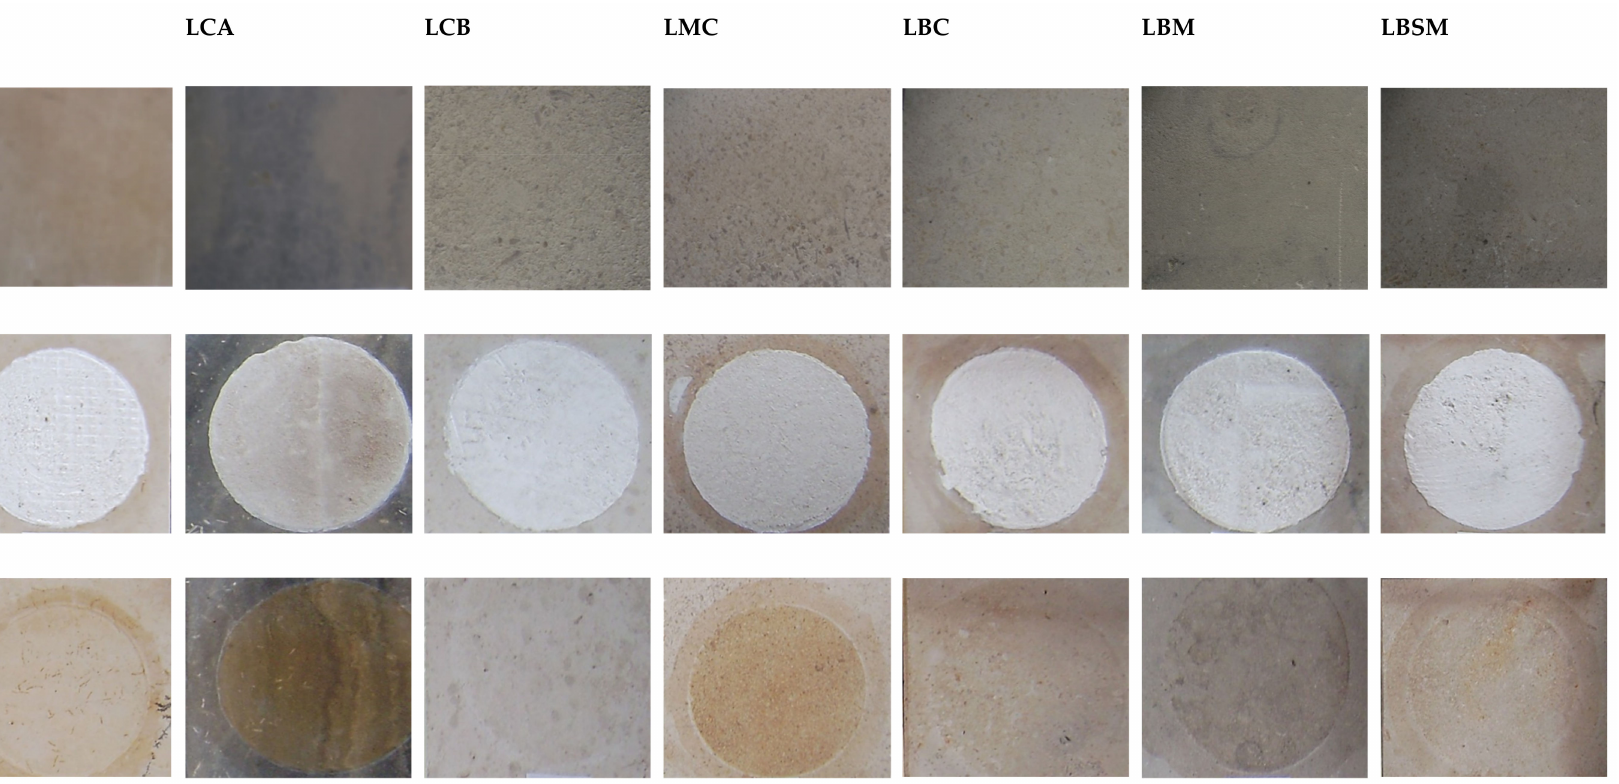
Figure 8. Samples of limestone stones before and after exposure to citric acid and hydrochloric